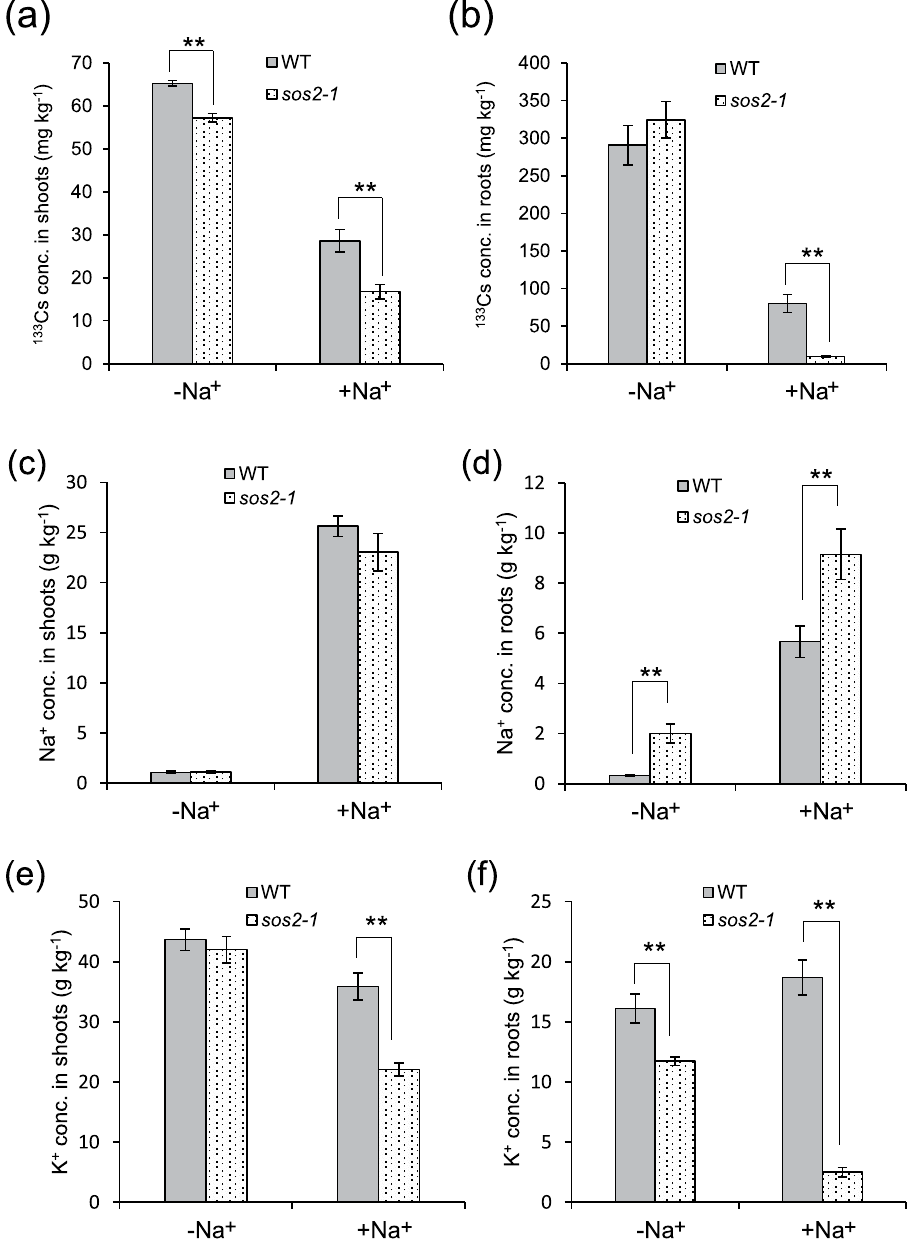
Figure 6. Effect of Na + on the concentrations of 133 Cs, K + , and Na + in the shoots and roots of Arabidopsis thaliana Columbia (WT) and sos2-1 mutant. ( a,b ) 133 Cs concentrations in ( a ) shoots and ( b ) roots. ( c,d ) Na + concentrations in ( c ) shoots and ( d ) roots. ( e , f ) K + concentrations in ( e ) shoots and ( f ) roots. Three-week- old plants grown in MS medium were treated with nutrient solution containing 1 µ M Cs + , 1 µ M Rb + and 10 mM Na + under low-K + (0.05 mM) conditions for 6 days. Data are means ± SD of three biological replicates. ** P < 0.01 ( t